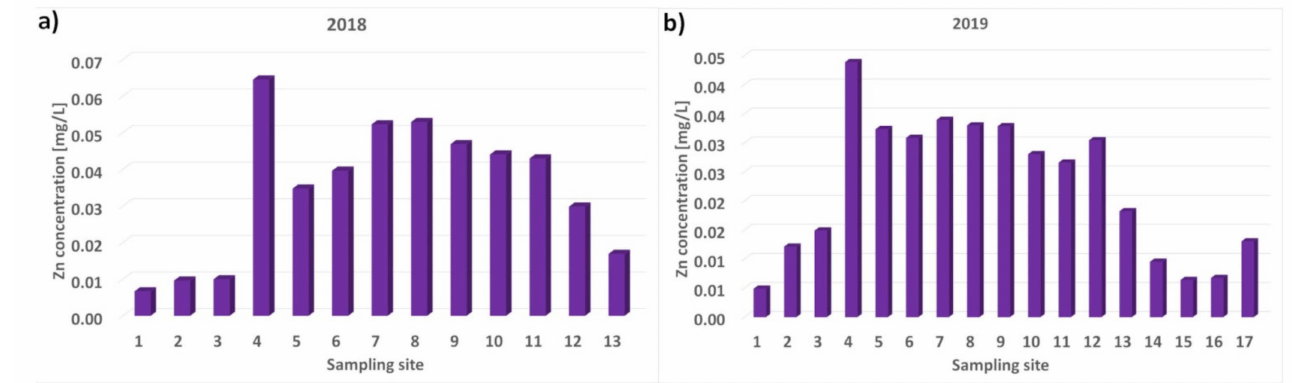
Figure 4. Median values of Zn concentrations in 2018 ( a ) and 2019 ( b ) for individual sampling sites,